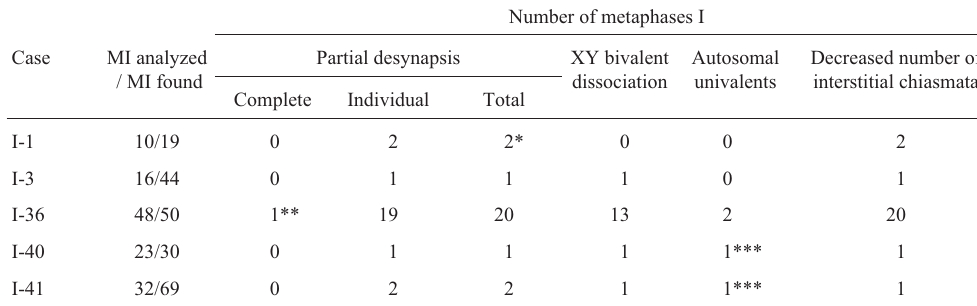
Table 3 - Metaphase I (MI) analysis in five infertile men presenting with meiotic desynapsis.